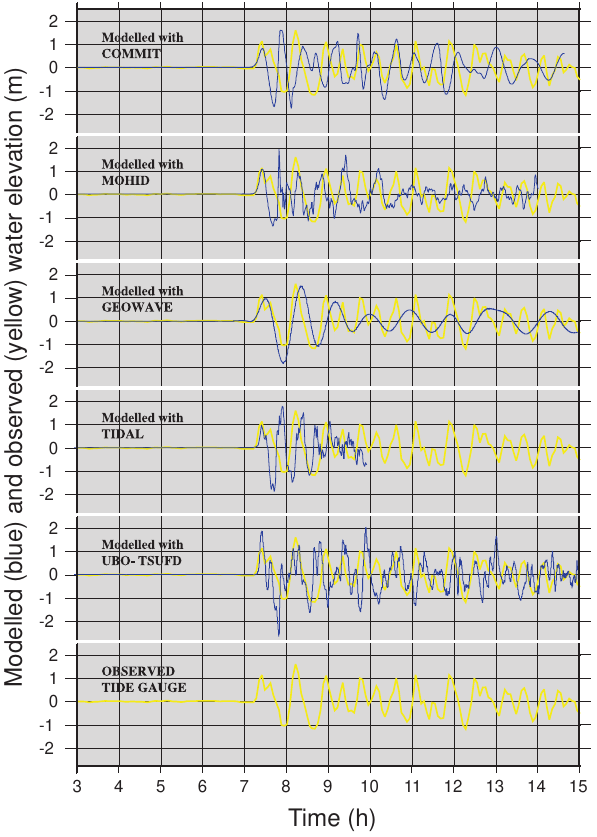
Fig. 2. Comparison between the real tide gauge recorded at Pointe La Rue (Mah´e island, Seychelles) during the 26 December 2004 tsunami and different synthetic tide gauges generated by the numer- ical codes used in the framework of SCHEMA project (modified after SCHEMA Consortium, 2007). The first-wave arrival times of the synthetic signals have been fitted to the real one to make the comparison